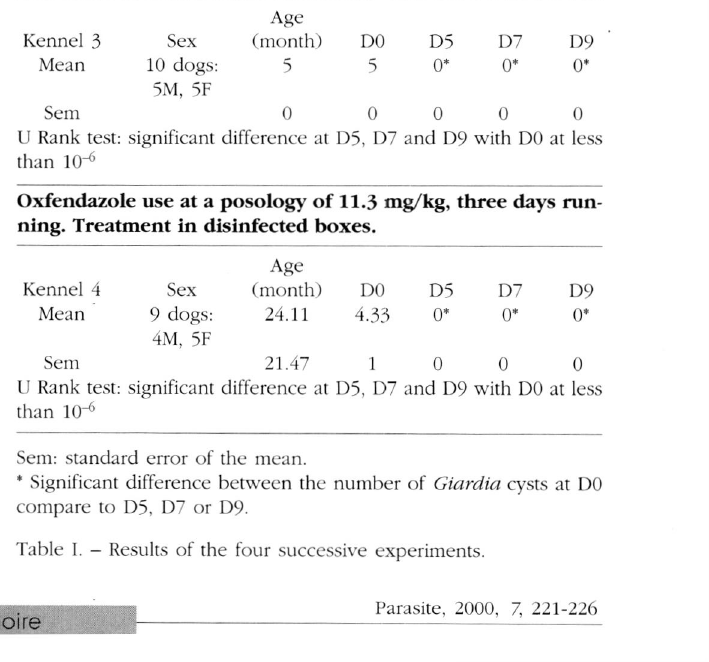
Sem: standard error of the mean. * Significant difference between the number of Giardia cysts at D0 compare to D5, D7 or D9. Table I. - Results of the four successive